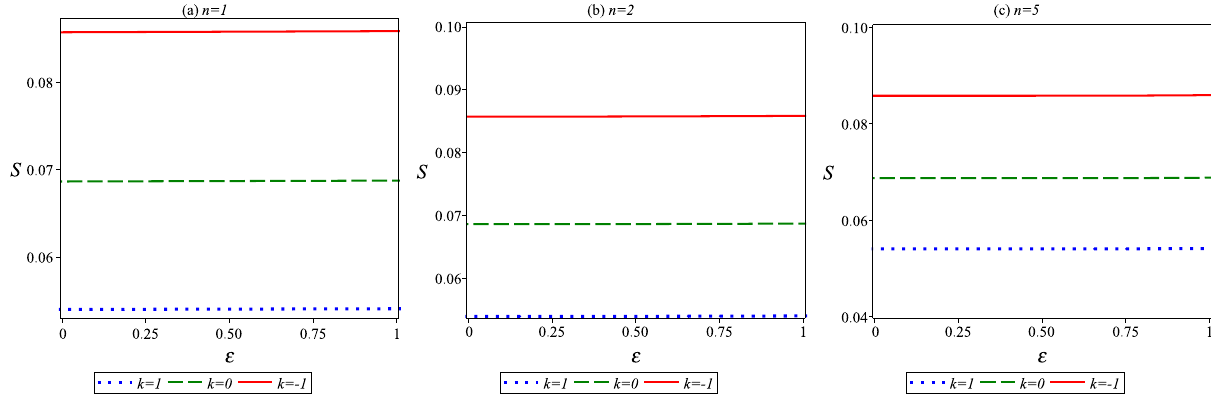
Fig. 2 Entropy of the first model (Eq. (3.6)) in terms of ε for η = 0 . 001, and r + = 0 . 60 ( k = 1), r + = 0 . 65 ( k = 0) and r + = 0 . 70 ( k = − 1)